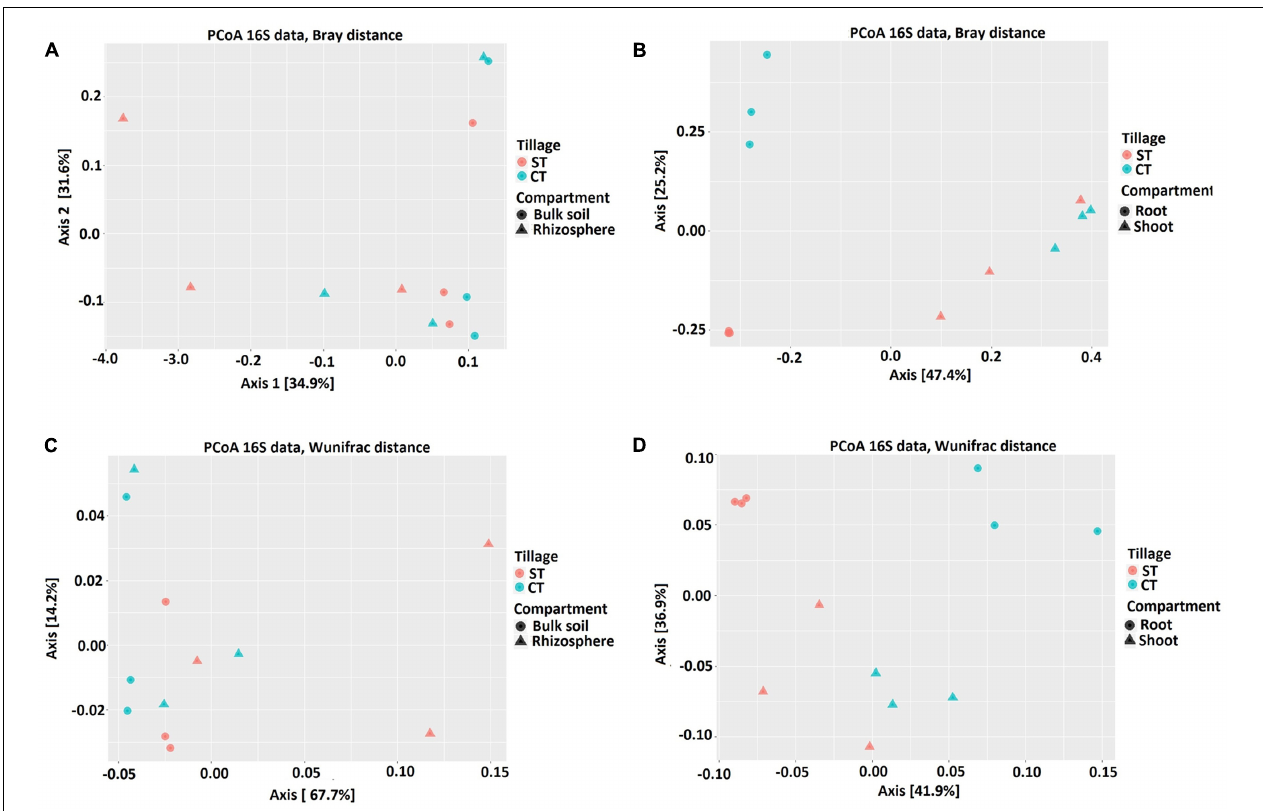
FIGURE 3 | Bacterial community structure of bulk soil, rhizosphere, root and shoot under CT and ST tillage practices. Principal Coordinate Analysis (PCoA) based on Bray-Curtis (BC) and Weighted UniFrac (WUF) distances calculated using counts per million transformed OTU abundances. Comparison between the soil samples; bulk soil and rhizosphere (A) BC (C) WUF under CT and ST. Comparison between the plant samples; root and shoot (B) BC (D) WUF under CT and ST. In both panels, colors define the tillage regimes, while shapes depict the indicated compartments. Statistical results of beta diversity are displayed in Supplementary Excel File WS-2.